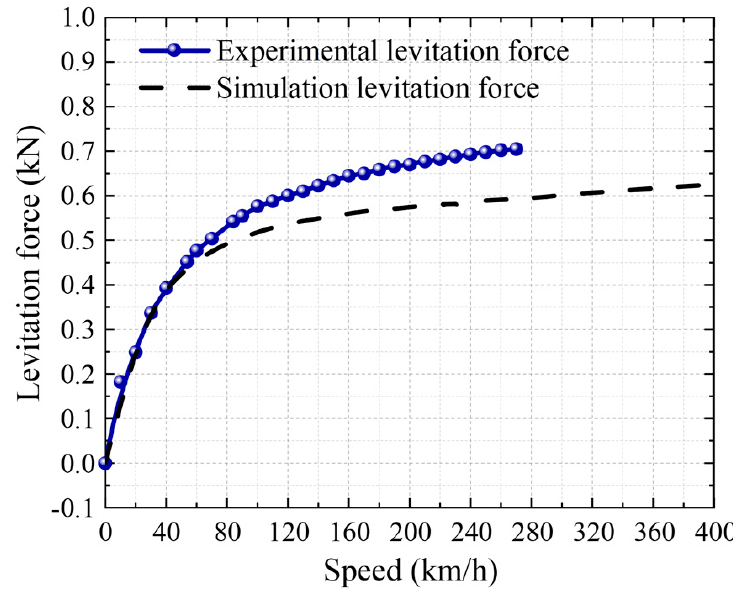
Figure 5. Comparison of experimental and simulation forces. Table 2. Parameters of the guidance system finite element model.